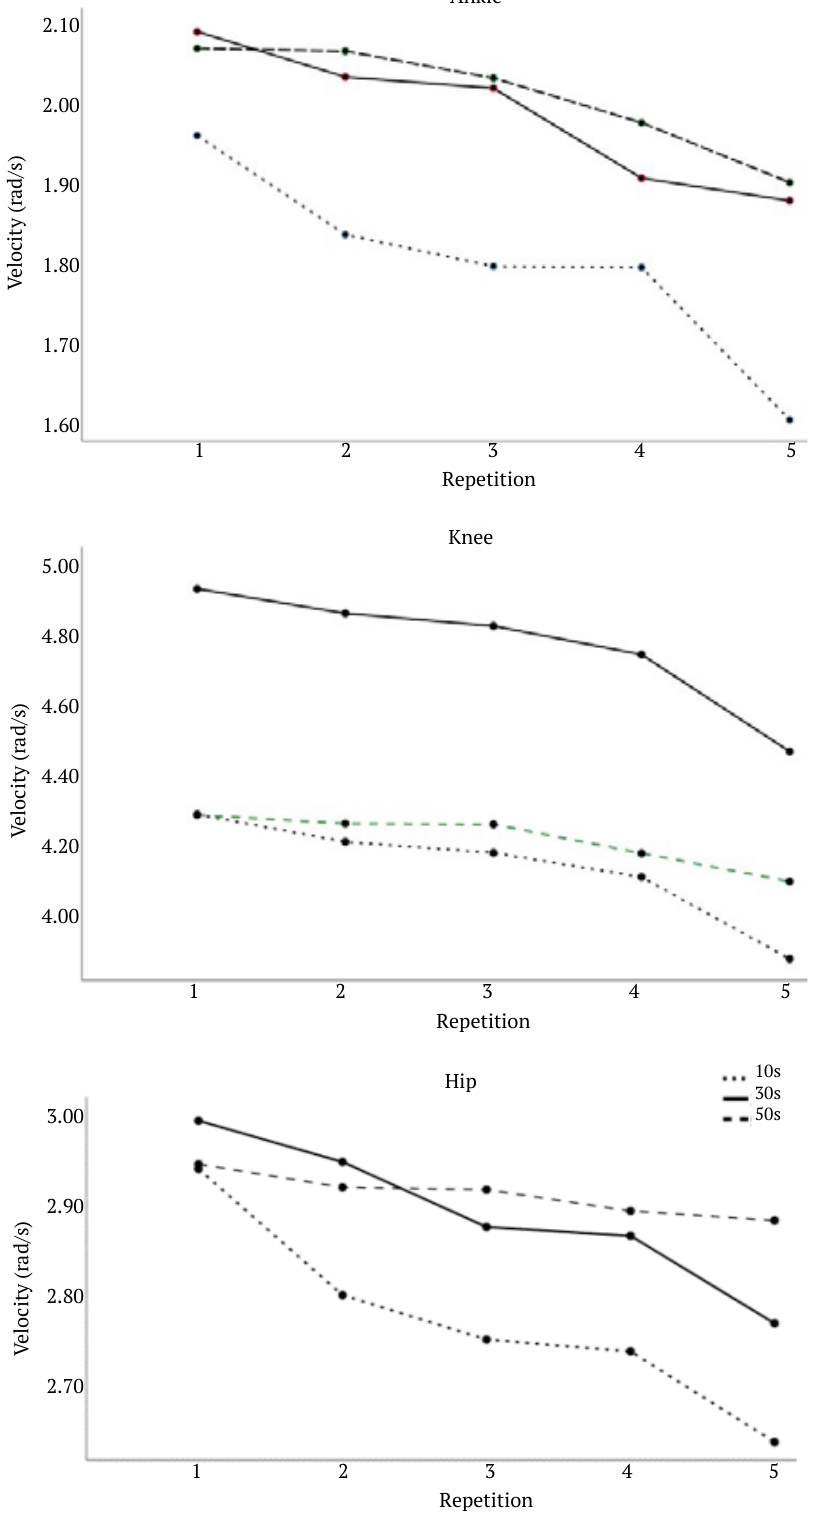
Figure 1. Peak Joint Kinematics at Snatch First Pull from Various Inter-repetition Rest